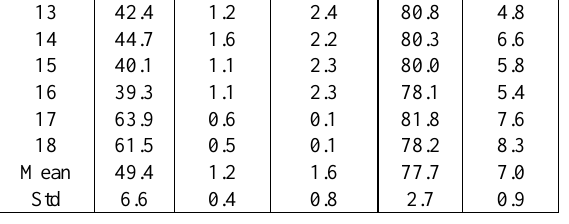
Table 3. Quality evaluation results of MWI data in Dunhuang